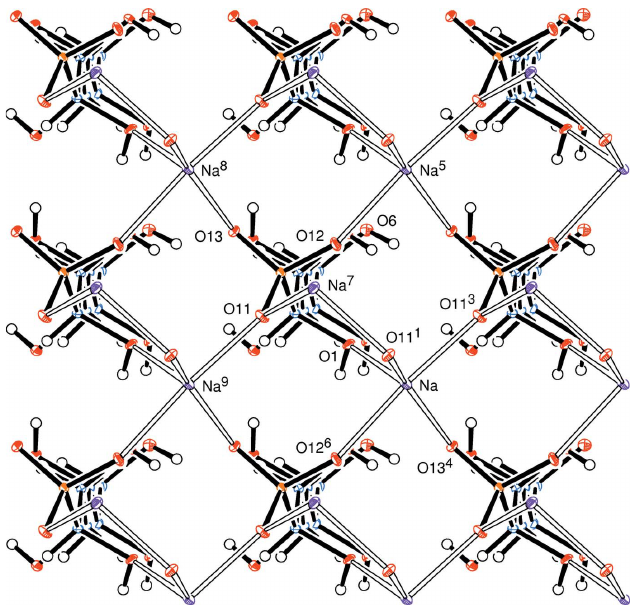
Figure 3 View looking along the all- trans sugar chain and neighbouring chains, all pointing in the same direction. Displacement ellipsoids are shown at the 30% probability level. Symmetry codes are defined as for Fig. 1.